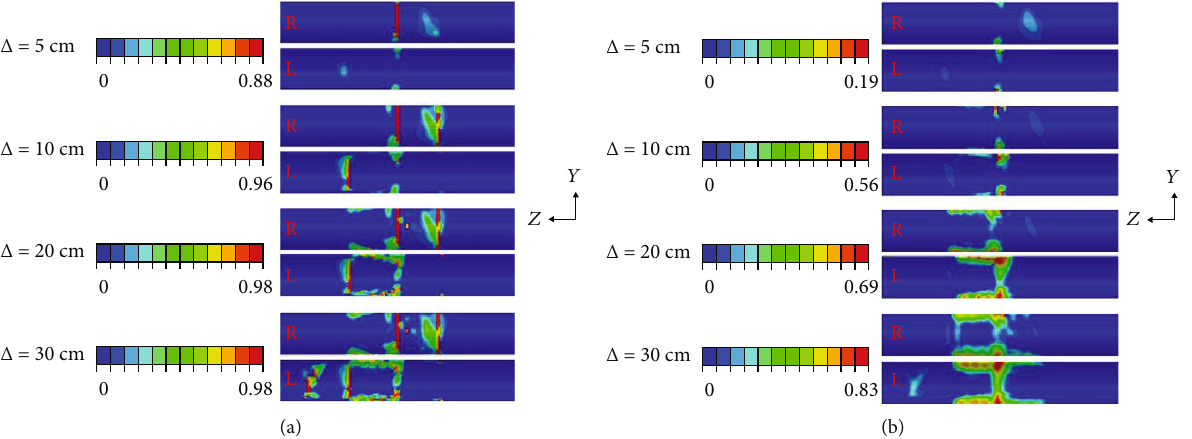
Figure 9: Tensile and compressive damage of tunnel lining under di ff erent fault displacements. (a) Tensile damage. (b) Compressive damage.